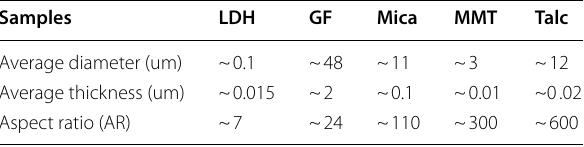
Table 2 Characteristics of the used fillers.